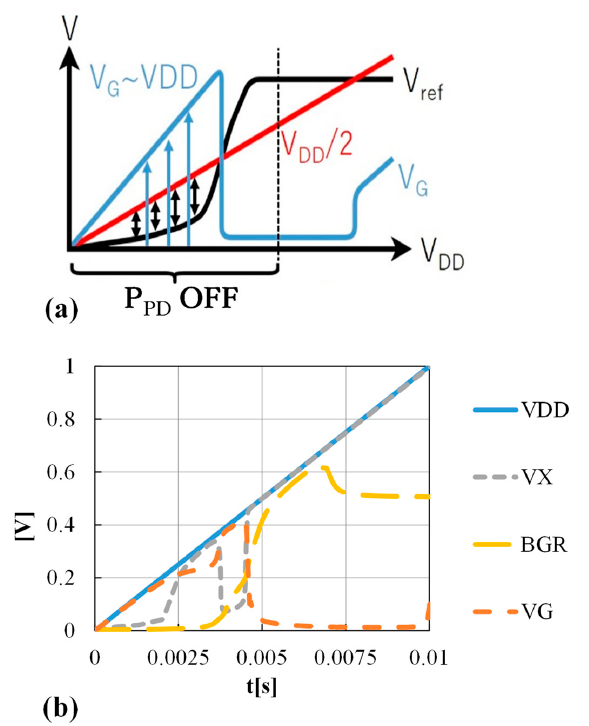
Figure 6. ( a ) Idea of a built-in POR and ( b ) the simulated waveform.